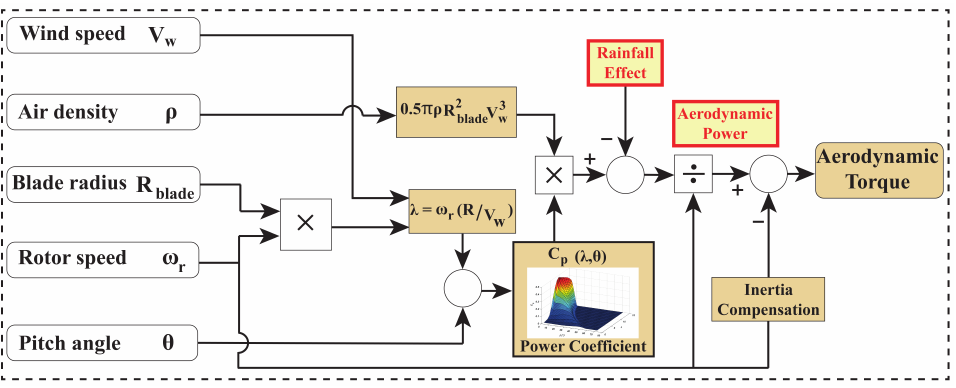
Figure 15. Block diagram of the WT modeling considering rainfall